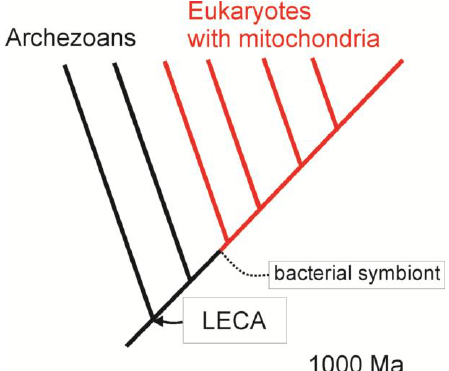
Figure 2. The archezoan hypothesis suggests that the last eukaryotic common ancestor (LECA) lacked mitochondria and had a relatively recent occurrence (<1000 Ma). By this view, several primitively amitochondriate eukaryotic lineages (in black) persist to the present along with mitochondriate lineages (in red).